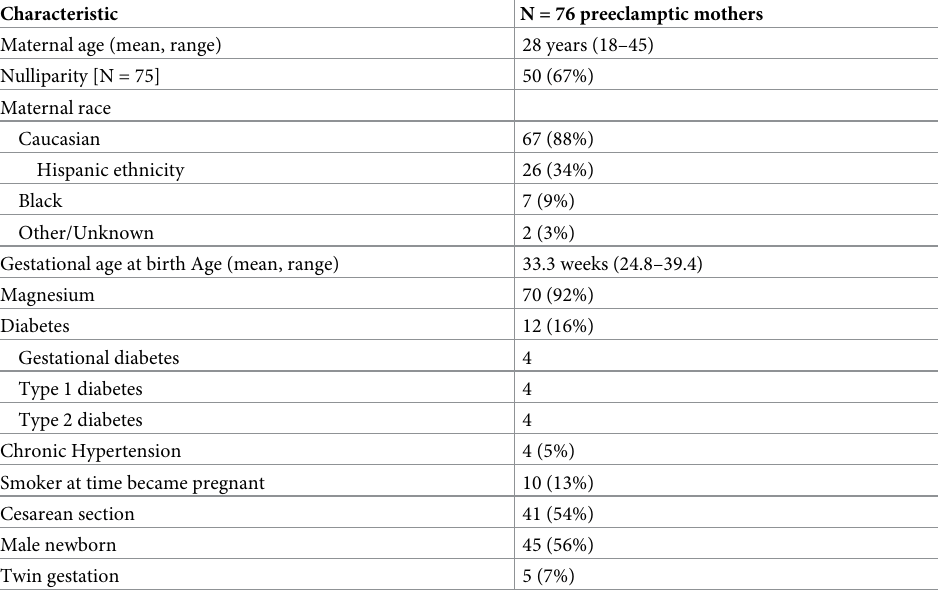
Table 1. Demographic and clinical characteristics of preterm preeclamptic